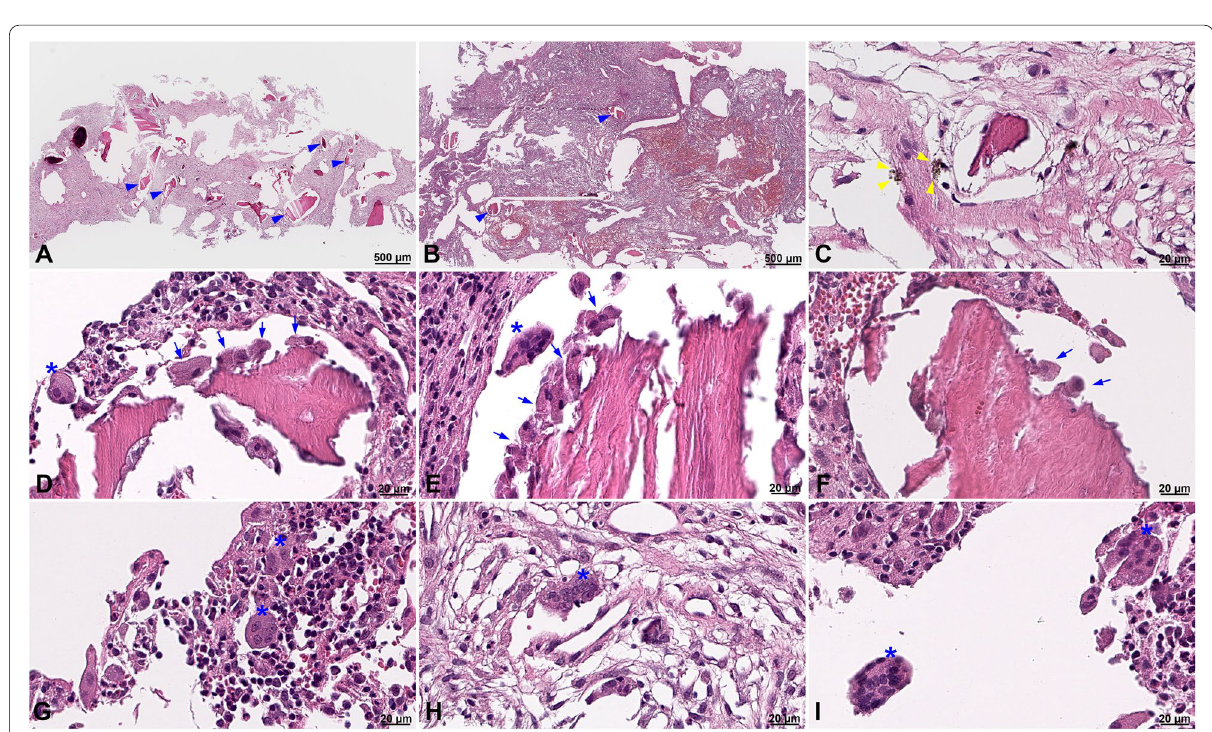
Fig. 7 Histological results of peri-implant tissue in case 1. There were bone particles scattered throughout the inflammatory tissue ( A , B blue arrowheads). Metal particles were observed ( C yellow arrowheads). Osteoclasts were apparent, surrounding the bone particles, supporting the progression of the bone-destruction process ( D – F blue arrows). Multinucleated giant cells were present in the bone particle area as well as scattered in the inflammatory tissue ( D – I blue